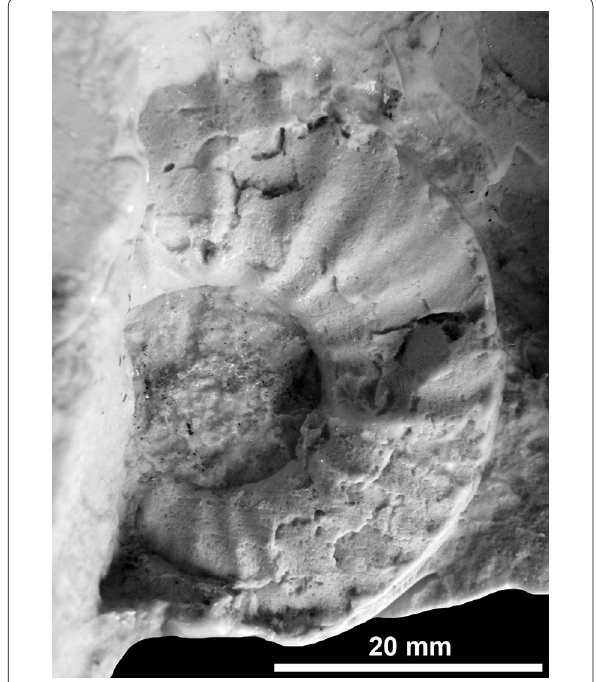
Fig. 4 Stoppaniceras cf. artinii (Airaghi, 1912a, 1912b) associated with PIMUZ 29942. Image obtained producing positive silicon cast from